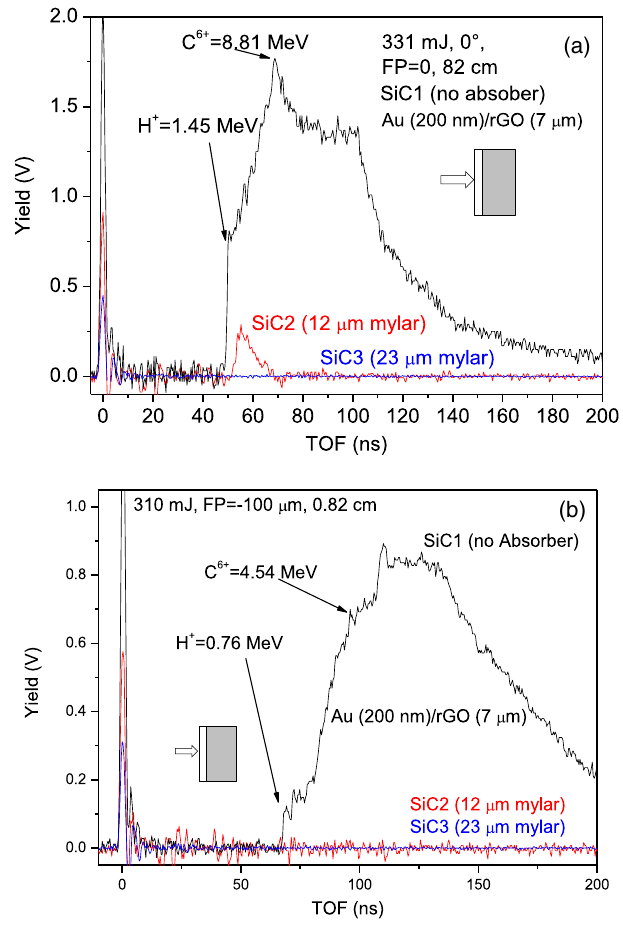
FIG. 6. SiC spectra obtained using a laser focal position of 0 microns (a) and of − 100 microns (b).